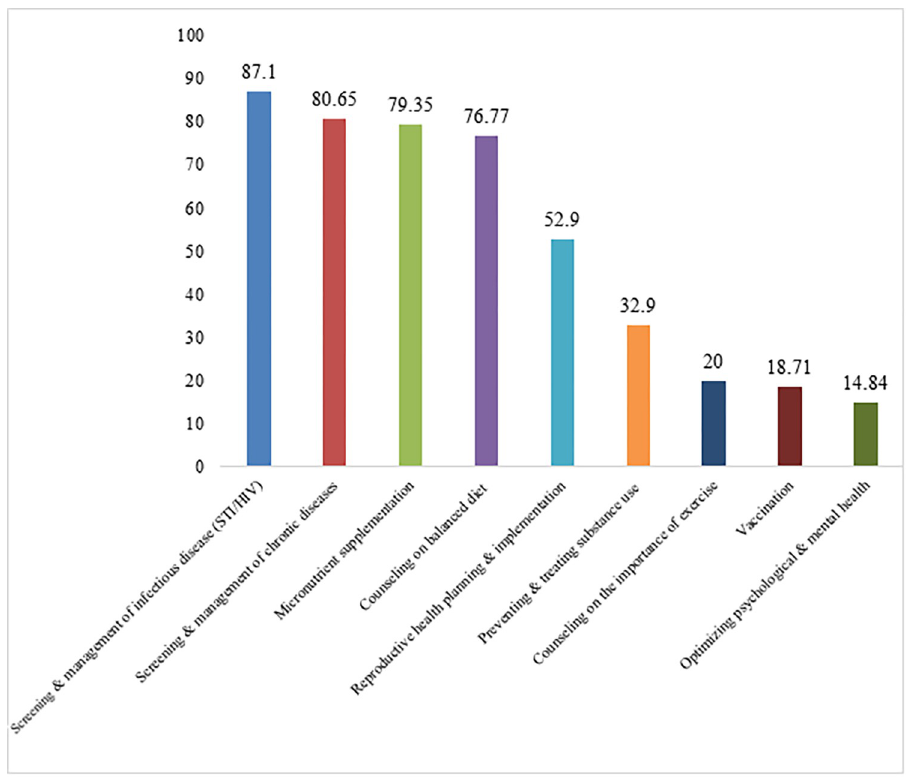
Fig 3. Percentage of WHO components of PCC utilization among pregnant women.